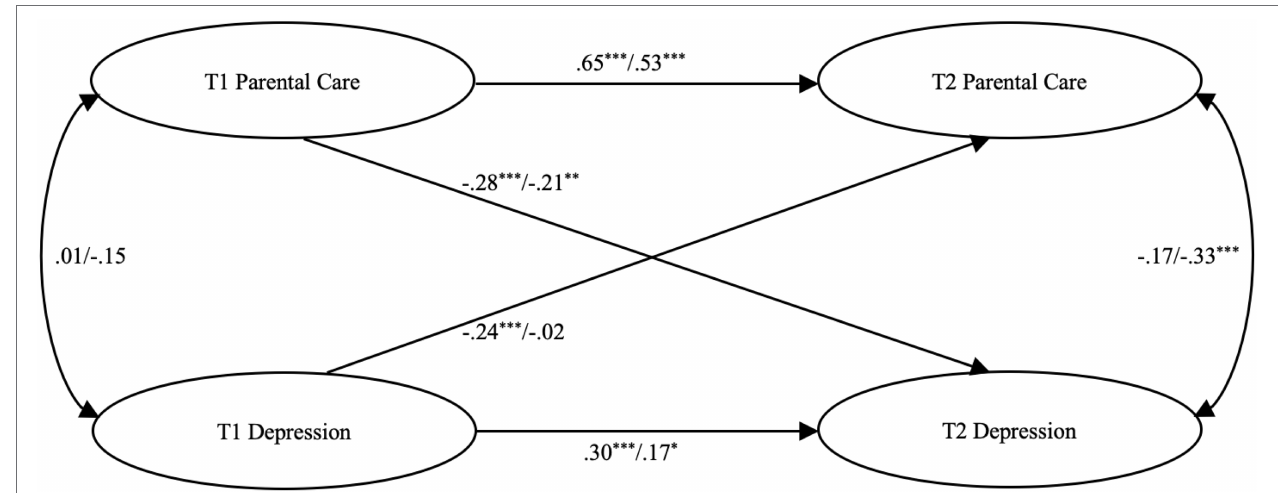
FIGURE 1 | Longitudinal structural equation model (SEM) model between parental care and adolescent depression. T1: CFPS data from 2010; T2: CFPS data from 2012. The values are correlations and standardized regression coefficients. Values to the left of the slash are for male participants and to the right of the slash are for female participants. Factor loadings for each latent construct can be found in Table 4 . * p < 0.05, ** p < 0.01, *** p <